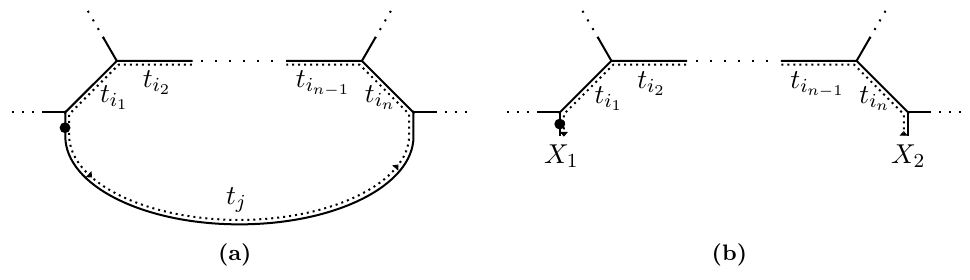
Figure 20. Cutting the edge E j in (cid:12)gure 20a leaves a connected, but not closed, border cycle joining two external edges marked X 1 and X 2 in (cid:12)gure 20b. To prove eq. (5.3) inductively we compare the string measures of the two